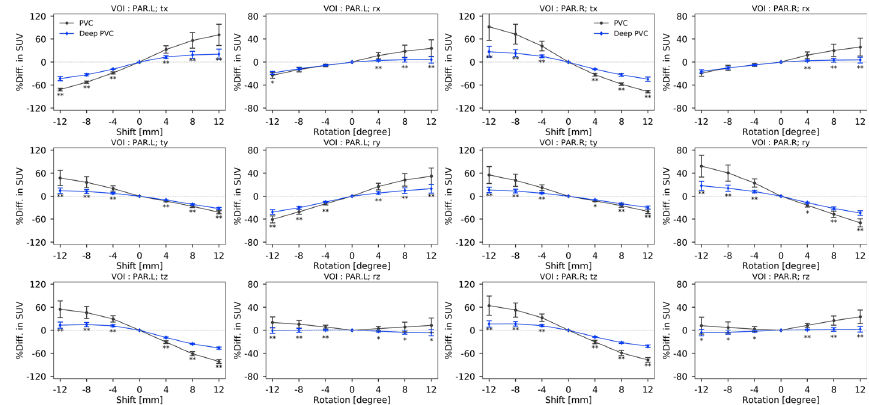
Fig. 8 Trends of the percentage differences in PV-corrected SUV on left (first and second columns) and right (third and fourth columns) parietal cortices in response to the shifts and rotations for RBV PVC and deepPVC. Asterisks indicate significant differences between RBV PVC and deepPVC (paired t test; * p < 0.05; ** p < 0.001). PV, partial volume; PVC, partial volume correction; RBV, region-based voxel-wise; SUV, standardized uptake value